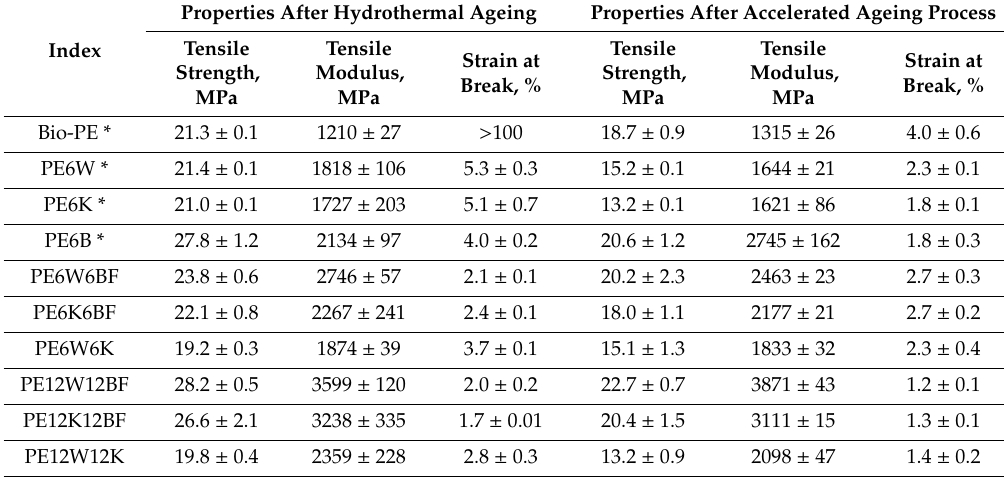
Table 2. Compassion of strength properties after hydrothermal and accelerated ageing